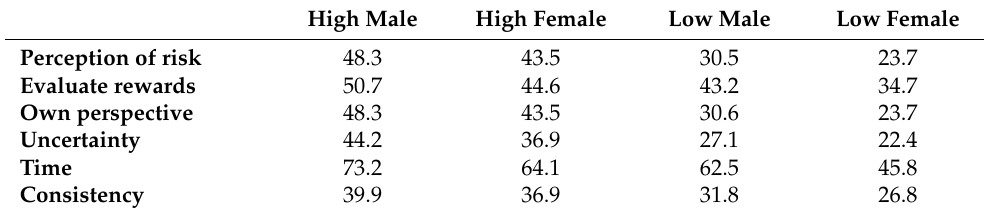
Table 3. REM groups by CRT group and gender (mean score, points out of maximum 100).